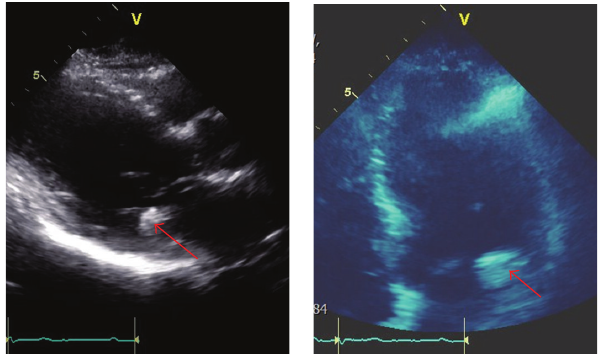
Figure 1: Transthoracic echo images demonstrating oval, heavily calcified echo-density on posterior mitral annulus that is difficult to differentiate from MAC (see arrow).